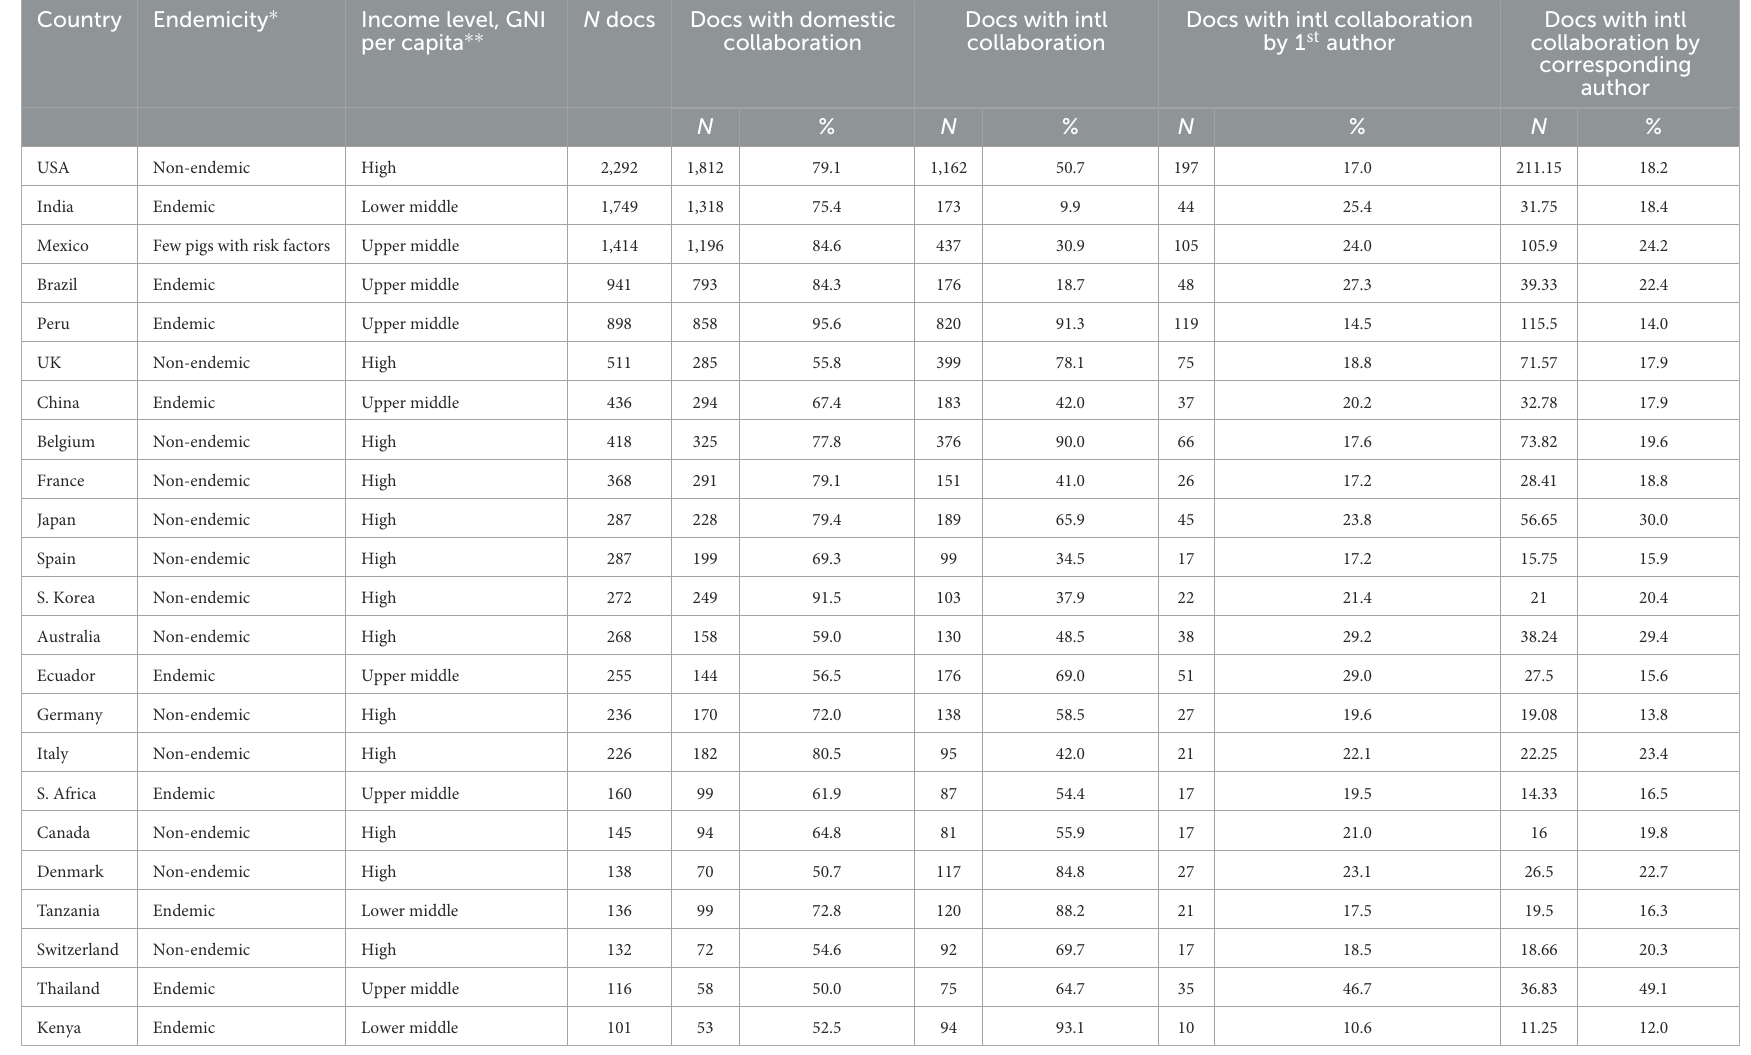
TABLE 4 Research production, collaboration, and leadership by country of institutional affiliations, in documents published on cysticercosis and neurocysticercosis and included in the Web of Science Core